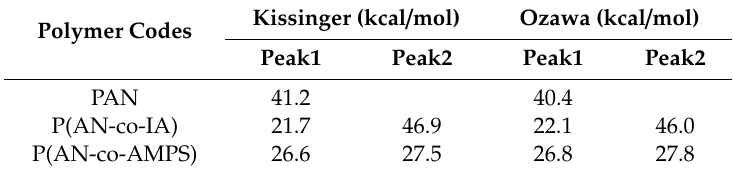
Table 2. Activation energy calculated from Kissinger and Ozawa methods.